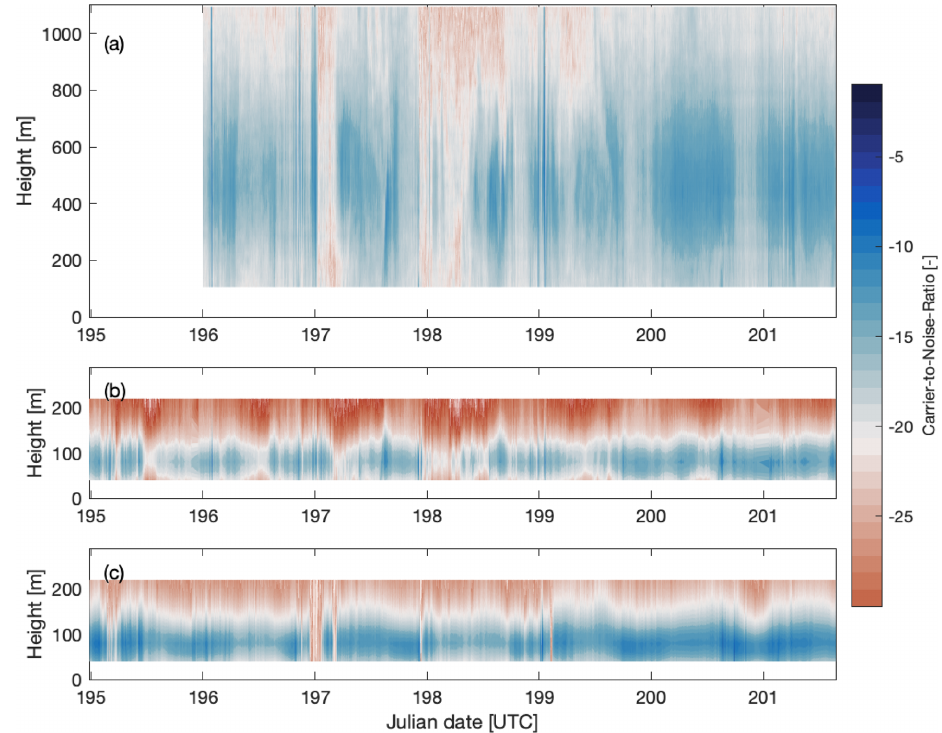
Figure 6. Time–height contours of carrier-to-noise ratio for the vertical velocity measured by the Halo Streamline (a) , the horizontal velocity measured by the WindCube WC49 (b) , and the horizontal velocity measured by the WindCube WC68 (c) for the duration of the field campaign. Data with CNR values above − 21 are used for the calculations (blue shading), whereas data with CNR below − 21 are discarded (red